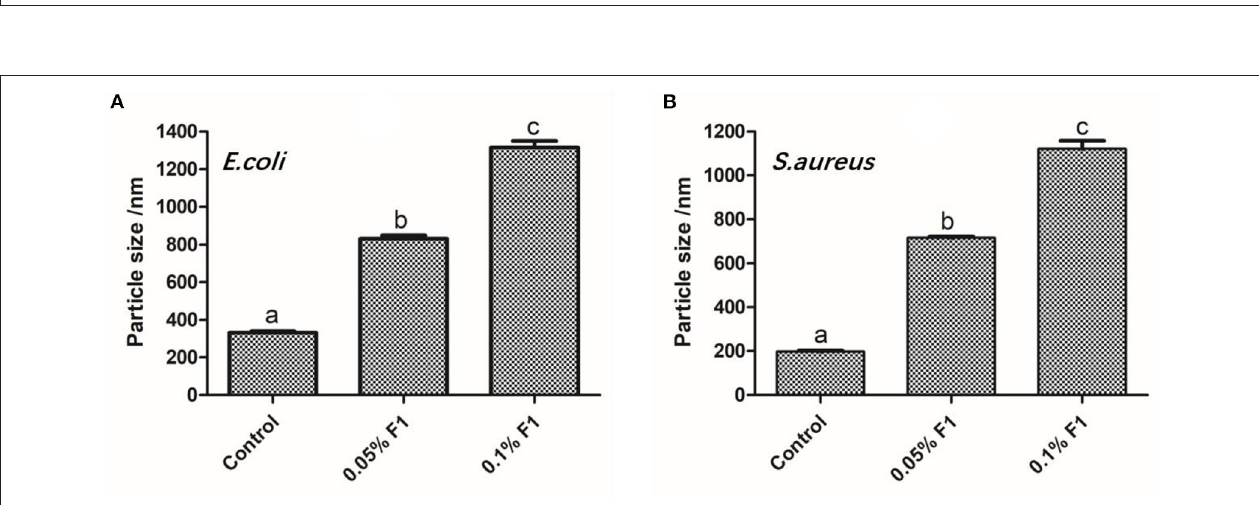
FIGURE 3 | The effect of different concentrations of antibacterial peptide F1 on phospholipids of E. coli (A) , and S. aureus (B) . These letter represent statistically significant difference among the groups at P < 0.05.